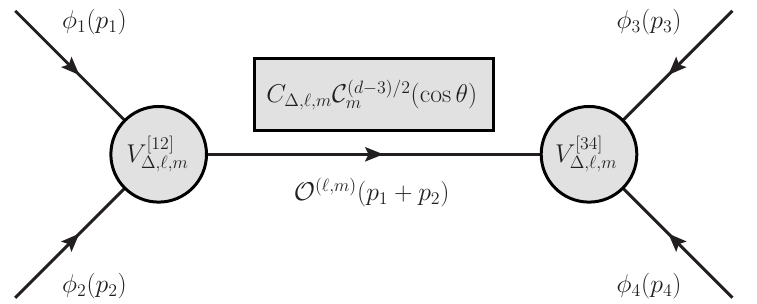
Figure 1: Diagrammatic representation of the conformal partial wave (1.4), in which each line corresponds to a local primary operator of the CFT carrying a certain mo- [ ab ] mentum. Note that the vertex functions V only depend on the scaling dimen- ∆ , (cid:96) , m sions, on the spin (the total spin (cid:96) and its projection m onto a reference direction), and on the momenta of the lines attached to